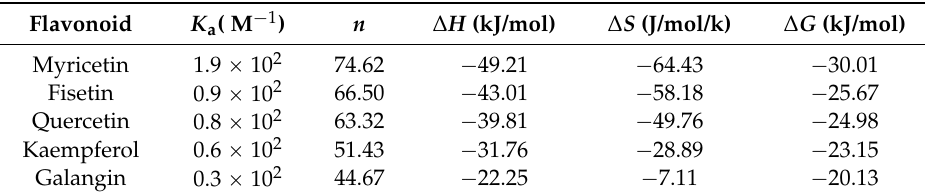
Table 4. The binding constant/stoichiometry and thermodynamic parameters for the binding of myricetin, fisetin, quercetin, kaempferol and galangin to ctDNA, as determined with ITC at 25 °C. “ n ”, possible number of binding sites; K a , binding constant; ∆ H , ∆ S and ∆ G , standard changes of enthalpy, entropy and Gibb’s free energy for per mole of respective flavonoid bound to ctDNA. Flavonoid